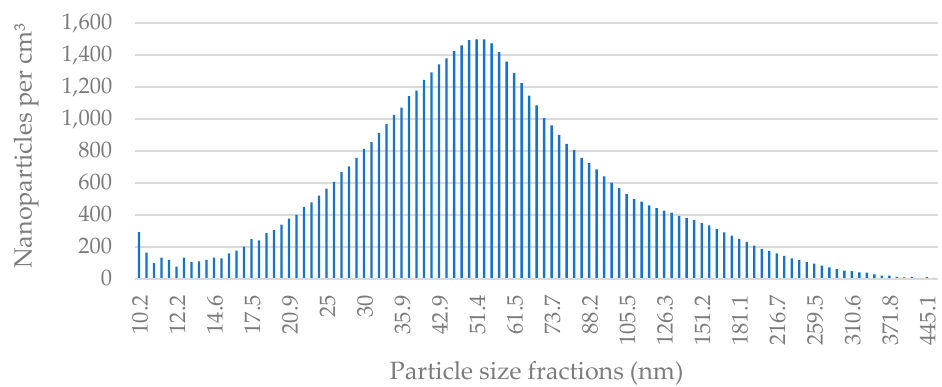
Figure A2. The average nanoparticle concentration in each size fraction in Building 1 during a one-week measurement period during the nonheating season.